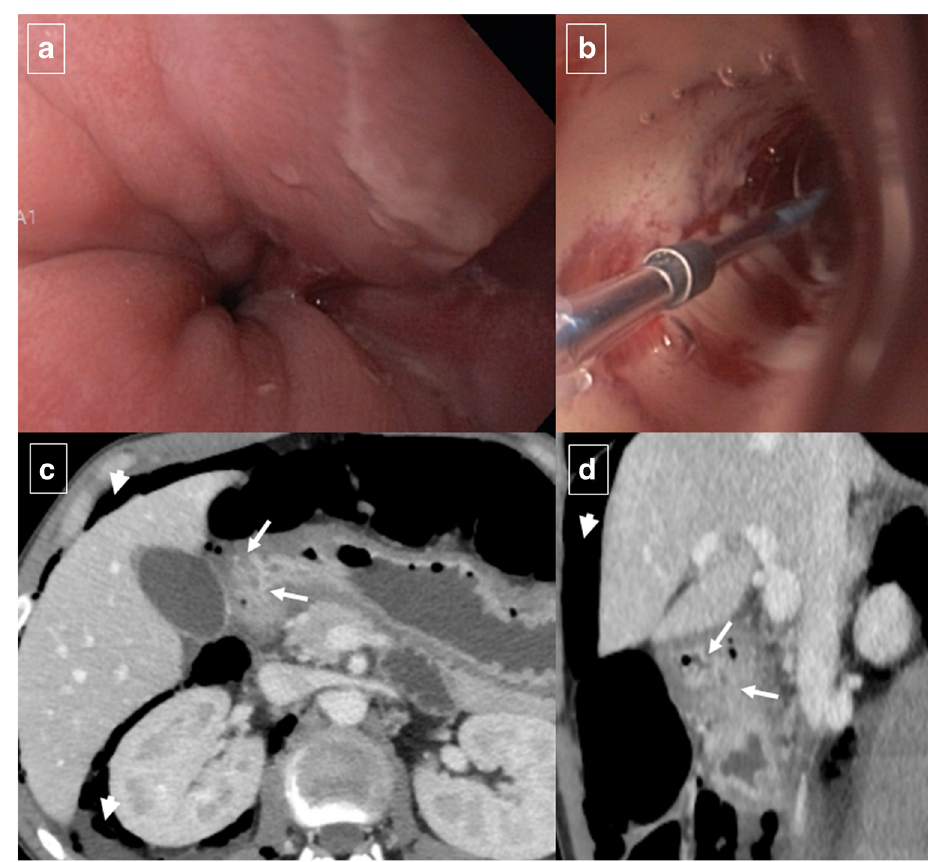
Fig. 18 A 24-year-old man with Crohn ’ s disease who presented with reflux esophagitis, daily vomiting, and food intolerance. a Upper endoscopy shows pyloric and bulbar involvement with ulcerated areas and folded hypertrophy that caused stenosis.